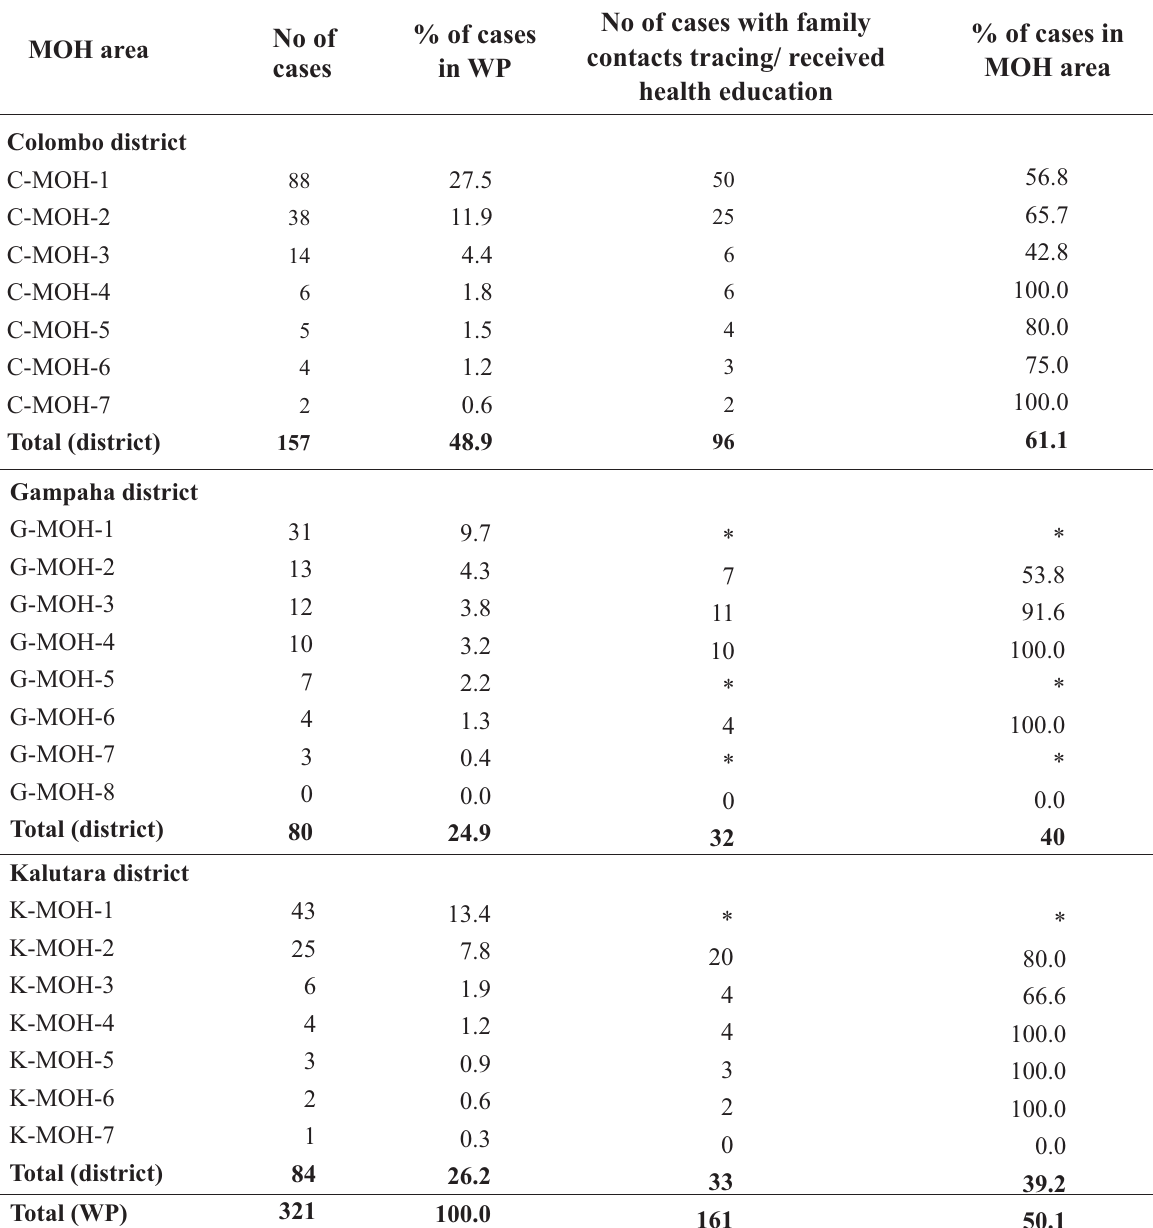
Table 5: Distribution of the status of contact tracing and health education at the field level by selected MOH areas in the Western